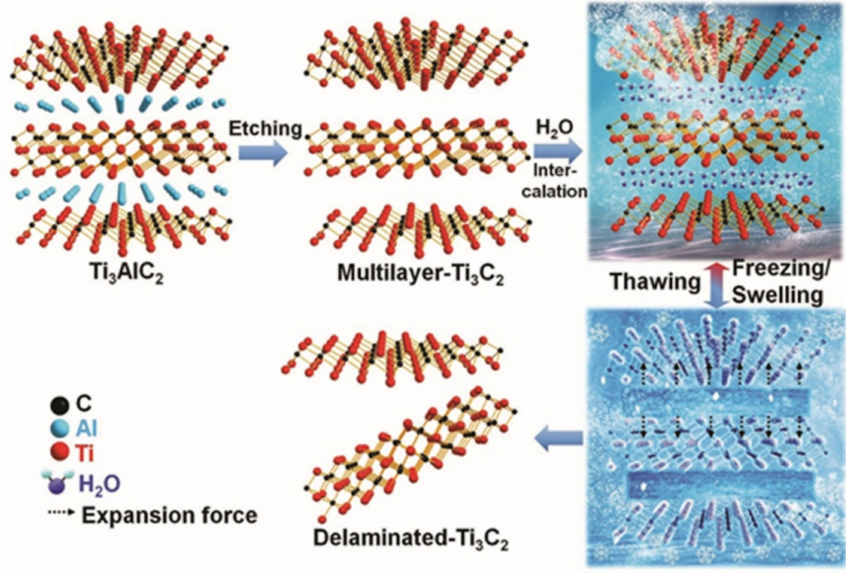
Figure 2. The synthesis process of FAT assisted method